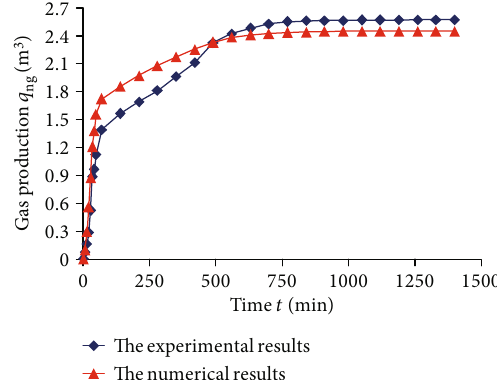
Figure 3: The variation of cumulative natural gas production with time in 3-D marine sediments for the whole o ff shore natural gas production process.